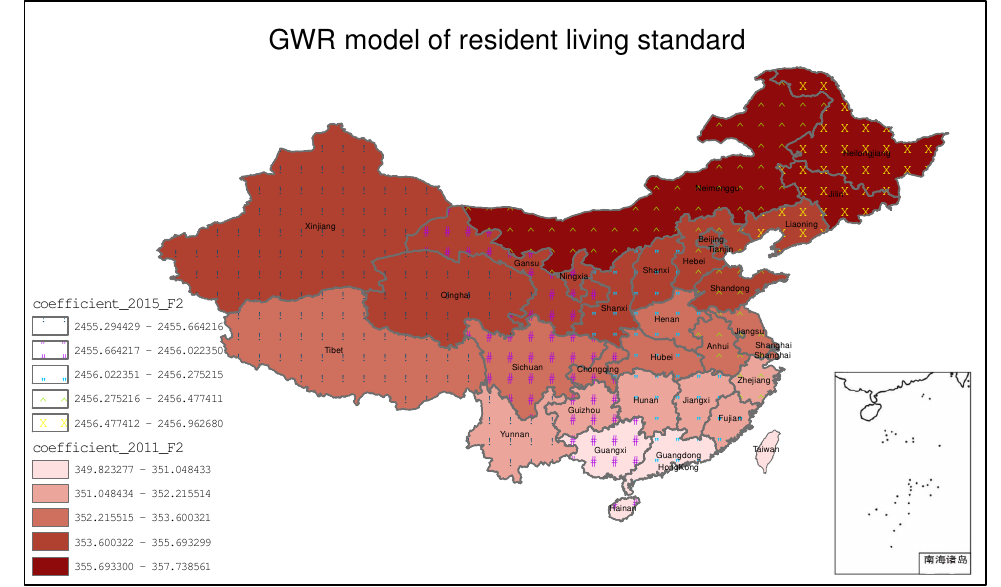
Figure 3. The regional difference map of resident living standard influencing factor in GWR